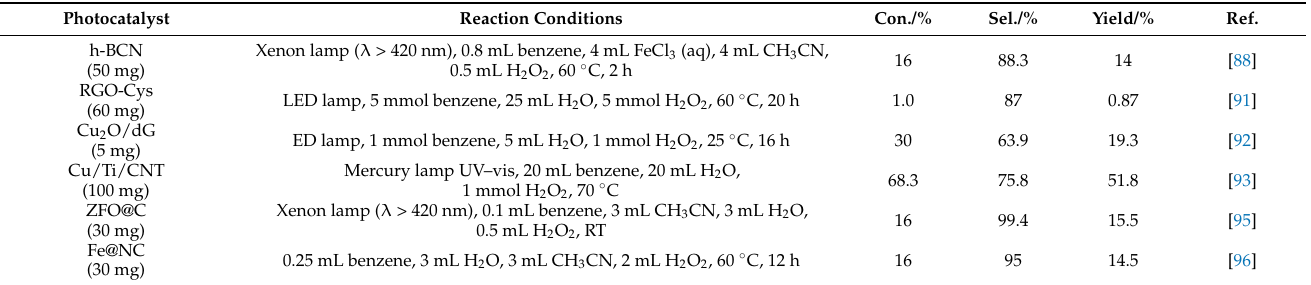
Table 5. Catalytic performance of carbon-materials-based photocatalysts for benzene hydroxylation. Reaction Conditions